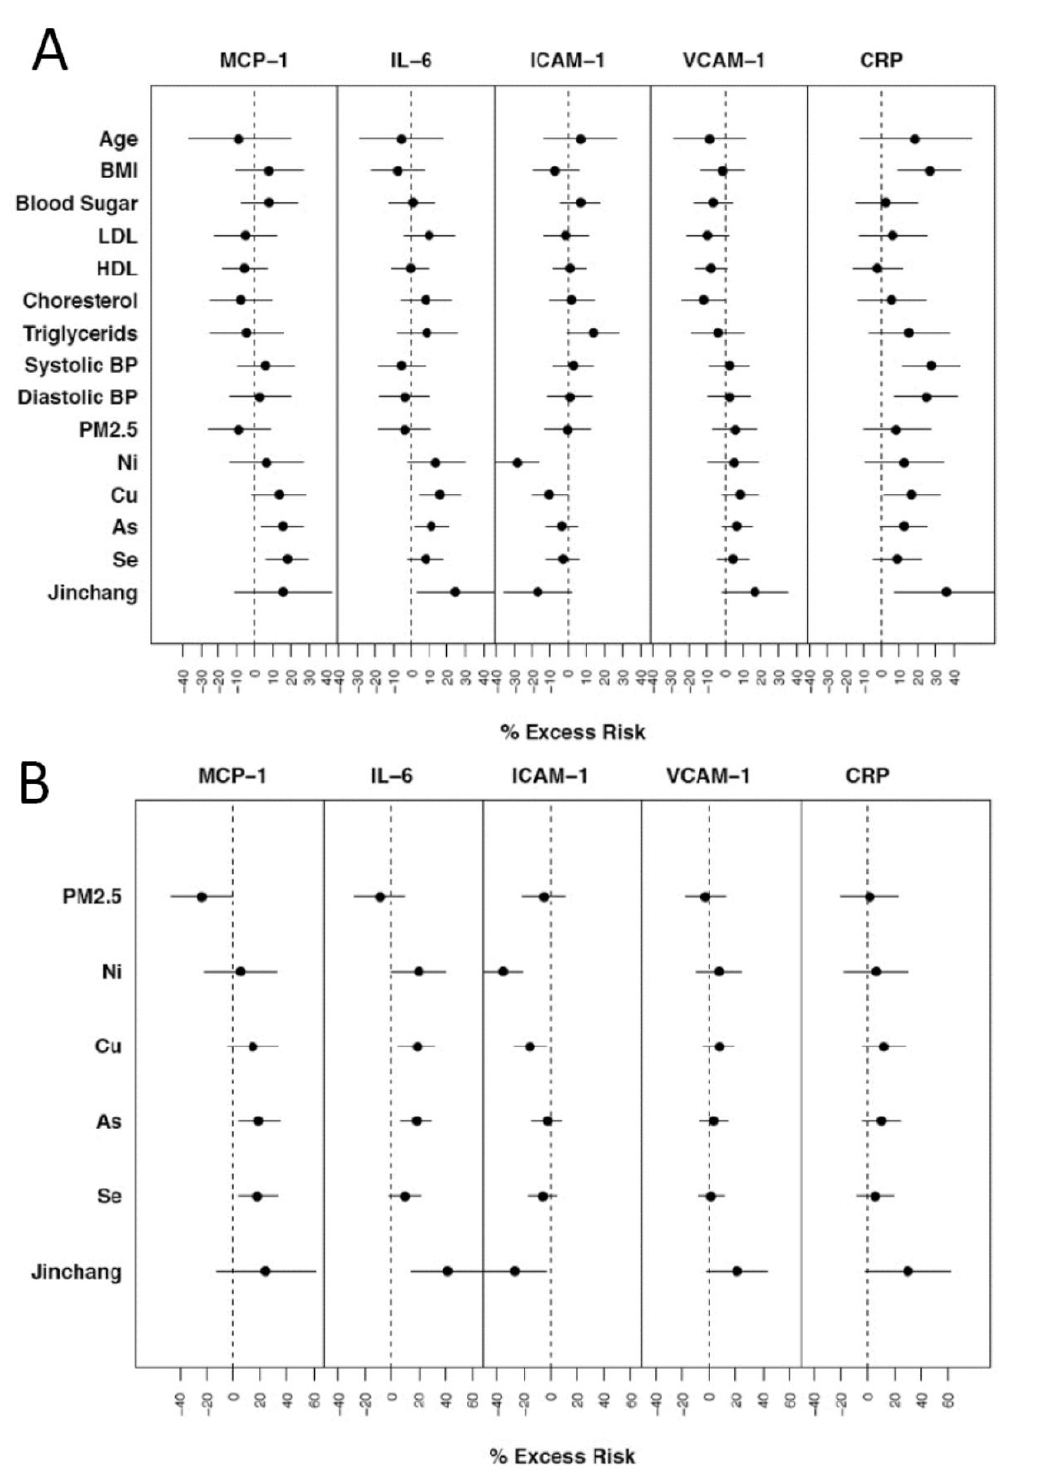
Figure 2. Percent excess risk from the mean values of biomarkers per inter-quartile-range increase in. : 1) risk factors and air pollution in univariate regression model. “Jinchang” is an indicator (Jinchang=1; Zhangye=0). Metal concentrations are log- transformed (Panel A); 2) PM2.5 and selected metals, adjusting for age, cotinine level, BMI, blood sugar, LDL, HDL, triglycerides, systolic and diastolic blood pressure. Metal concentrations are log-transformed (Panel B). doi: 10.1371/journal.pone.0083782.g002 PLOS ONE |